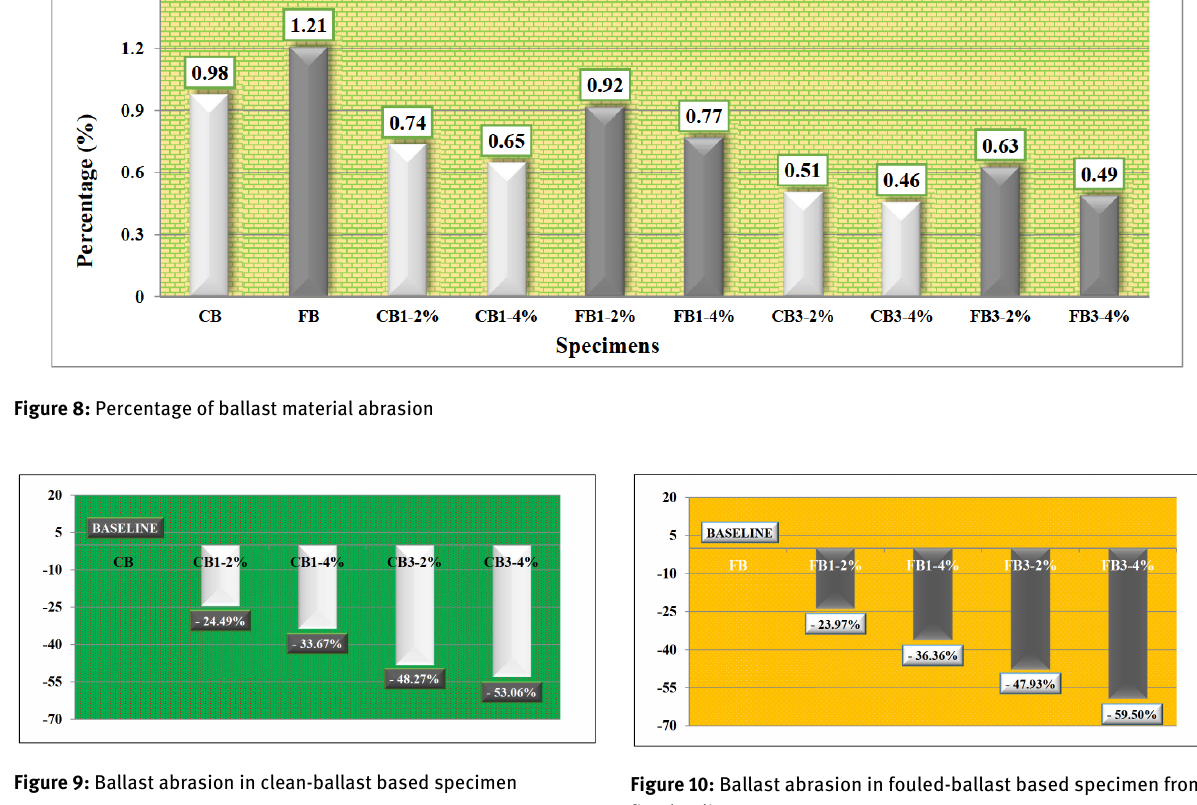
Figure 10: Ballast abrasion in fouled-ballast based specimen